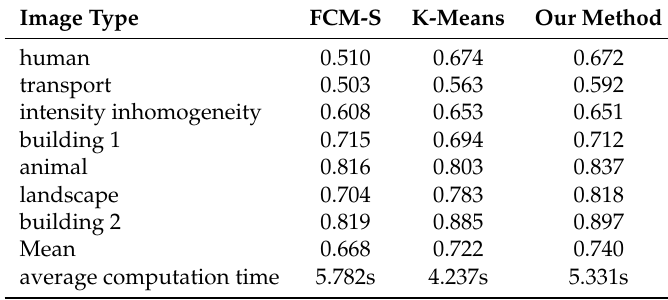
Table 1. Comparison of different method for Berkeley image dataset, Probabilistic Rand Index